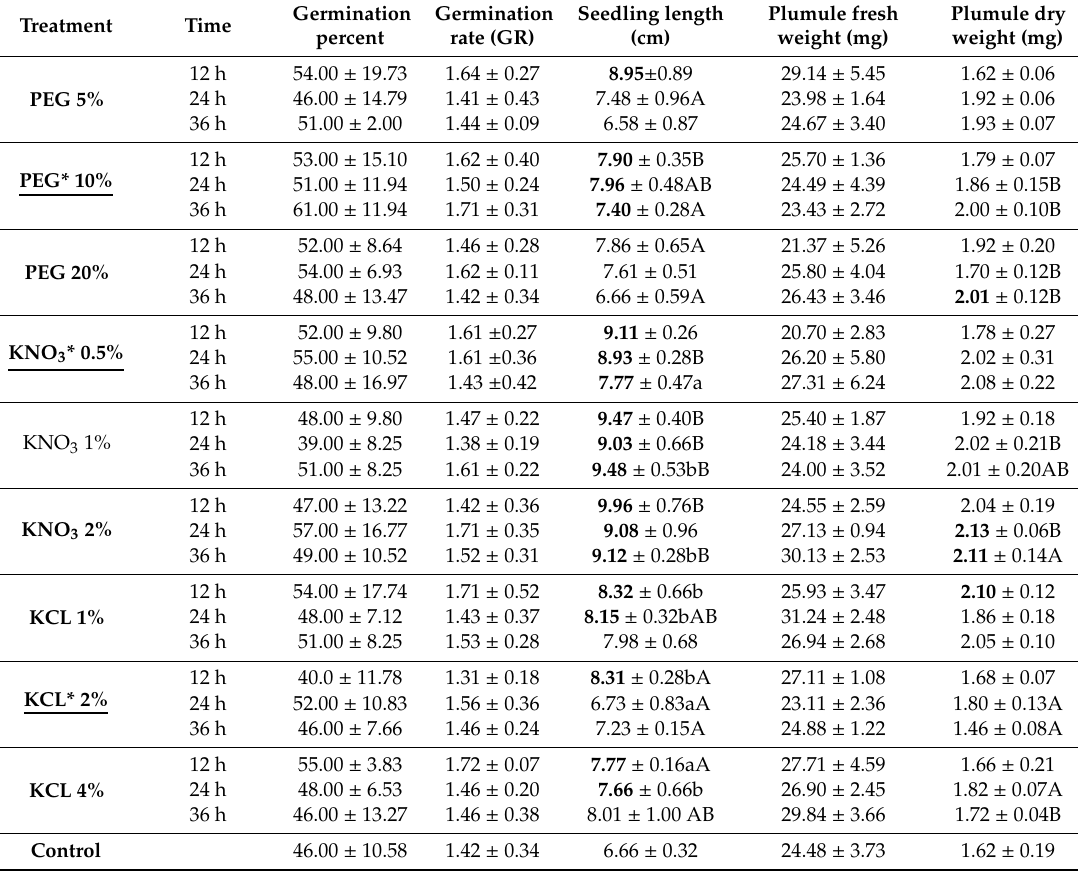
Table 1. Comparative analysis of caraway seed priming with PEG, KNO 3 and KCL on germination and seedlings characteristics in the Petri dish